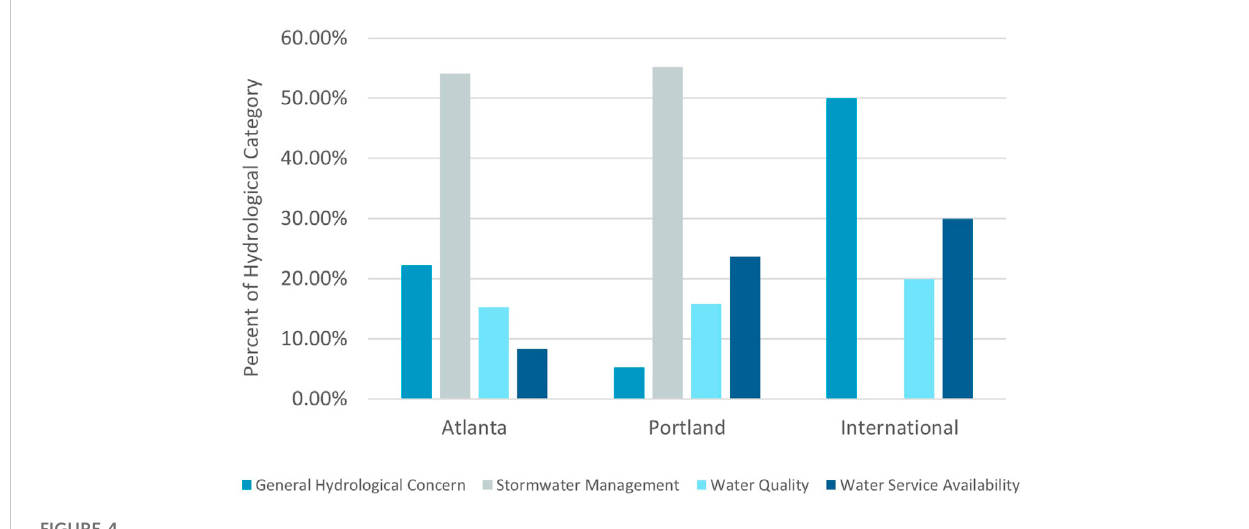
FIGURE 4 Subcategory fi ndings and comparison of Hydrologic